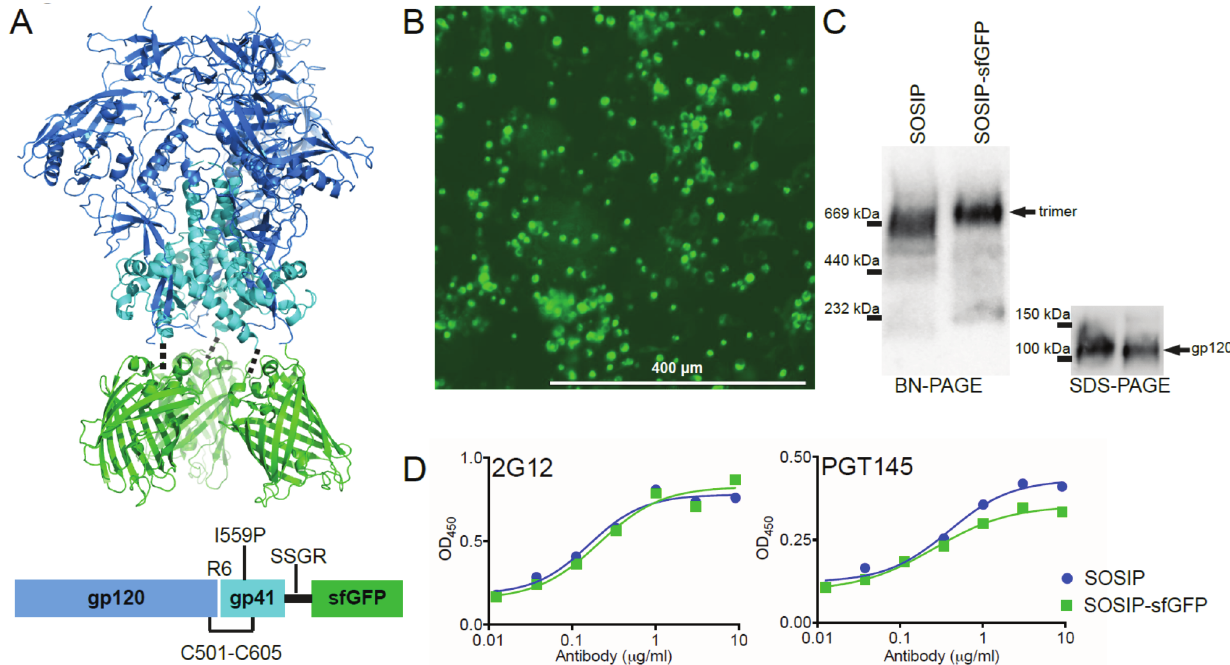
Figure 1. Design and expression of BG505 SOSIP.664-sfGFP (SOSIP-sfGFP). ( A ) Top: Model of SOSIP-sfGFP (BG505 SOSIP.664, PDB: 4TVP [13]; sfGFP, PDB: 2B3P